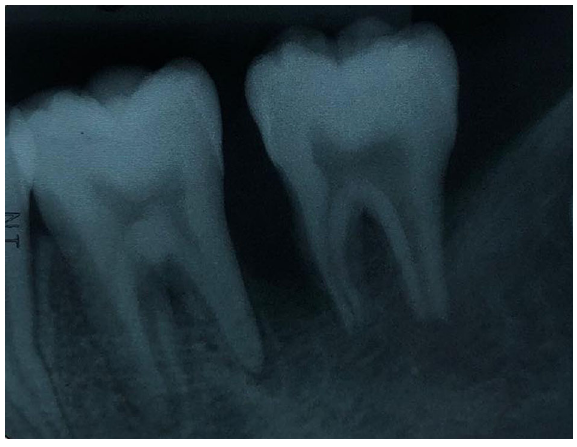
Figure 2. Radiographic examination. The periapical radiograph demonstrating alveolar bone loss at tooth no. 36 and tooth no. 37.